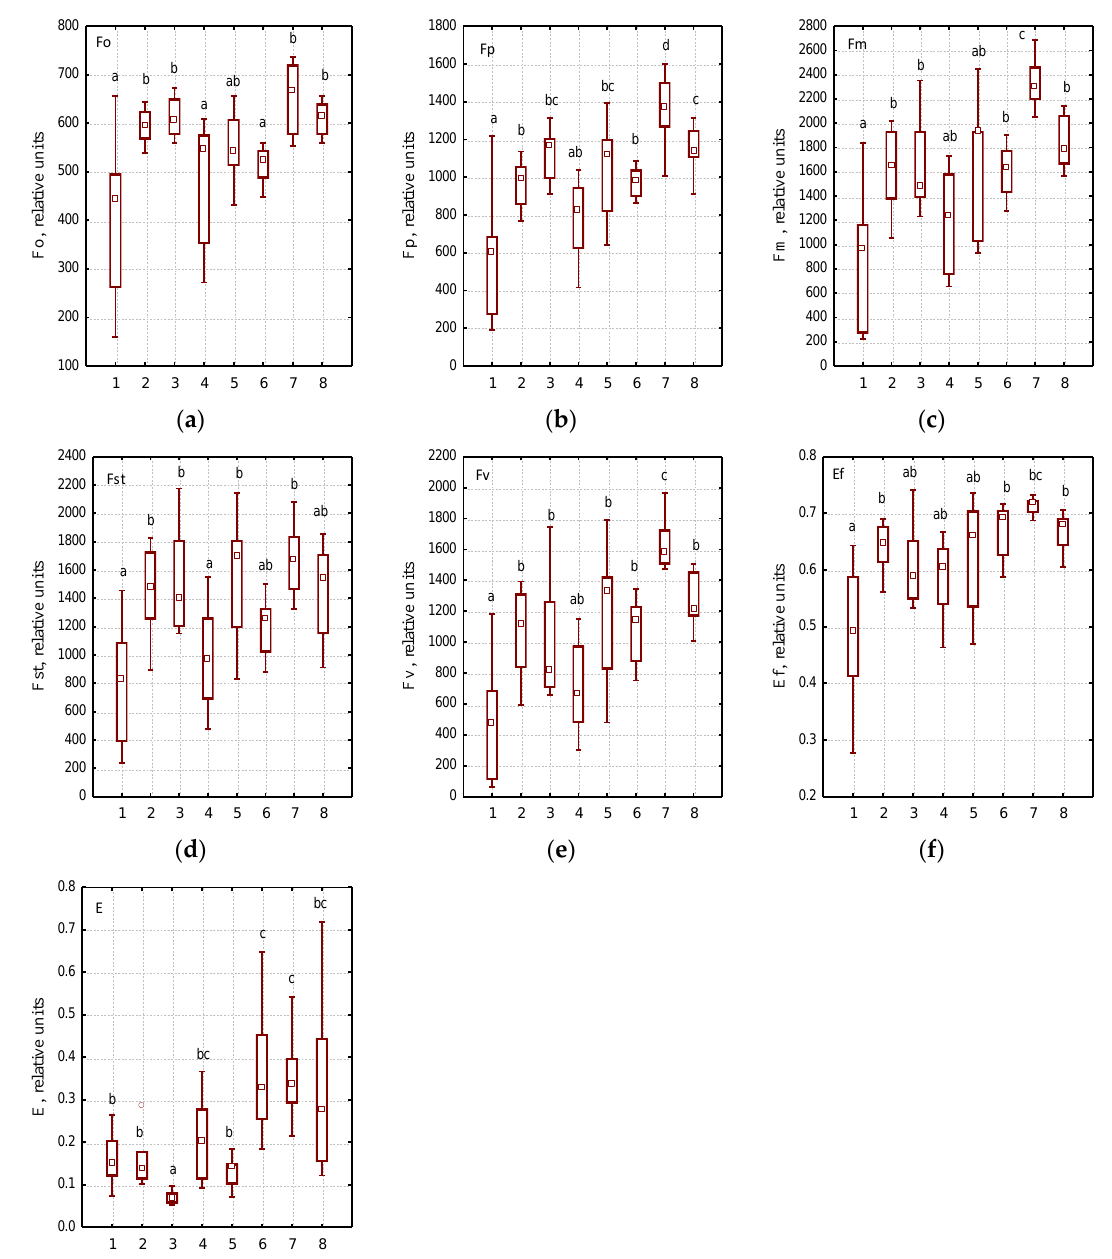
Figure 4 . Variability of photosynthesis characteristics in various urban parks of Dnipro city: ( a ) — F 0 — the initial value of fluorescence induction after switching on irradiation, ( b ) — F p — the value of fluorescence induction “ plateau ” , ( c ) — F m — the maximum value of fluorescence induction, ( d ) — F St — the steady value of fluorescence induction after light adaptation of the leaf of the plant, ( e ) — F V — variable chlorophyll fluorescence, ( f ) — Ef — the maximum efficiency of primary photosynthesis processes, ( g ) — E — efficiency coefficients of photochemical processes; at the x-axis: 1 — Botanical Garden of DNU, 2 — Novokodatskyi Park, 3 — Taras G. Shevchenko Park, 4 — Pridneprovsky Park, 5 — Metallurgists Square, 6 — Lazaria Hloby Park, 7 — Druzhby narodiv Forest Park, 8 — Park Sahaydak; at the y-axis: the values of parameters indicated in Table 1; please see Figure 3 for an explanation of statistical processing .